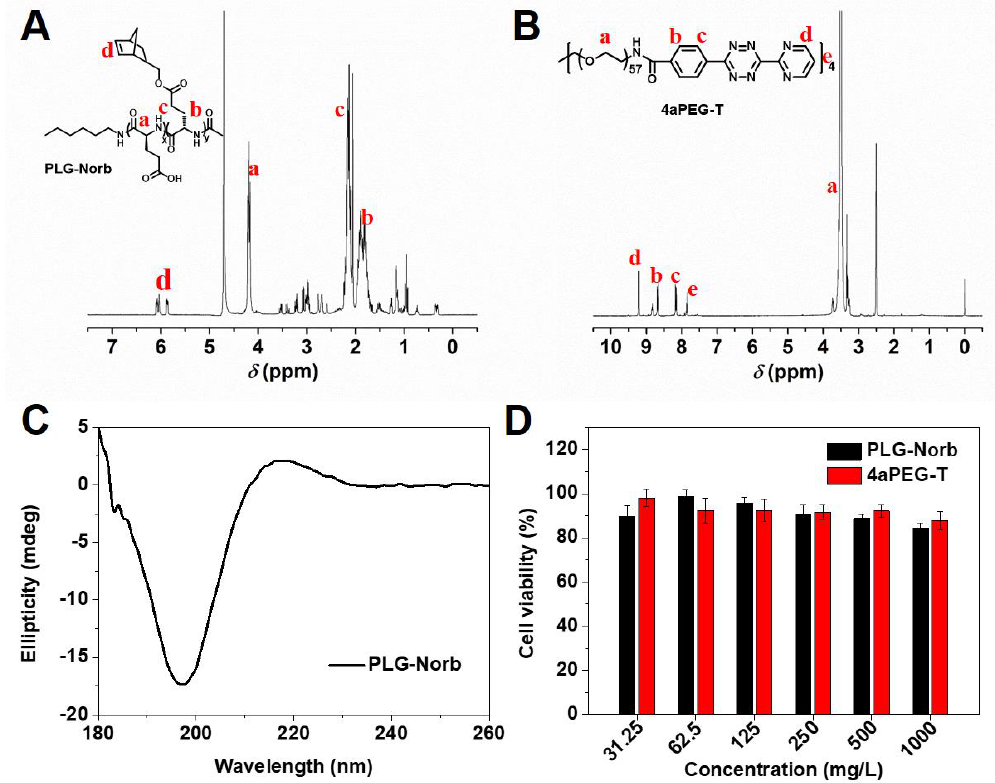
Figure 1. Representative 1 H NMR spectra of ( A ) PLG-Norb and ( B ) 4aPEG-T using D 2 O/NaOD and DMSO- d 6 as solvent, respectively. ( C ) Circular dichroism (CD) spectrum of PLG-Norb at 0.01 mg/mL in 5 mM PB (pH 7.4). ( D ) In vitro cytocompatibility of PLG-Norb and 4aPEG-T at different polymer concentrations against MCF-7 cells after incubation for 48 h ( n = 6).